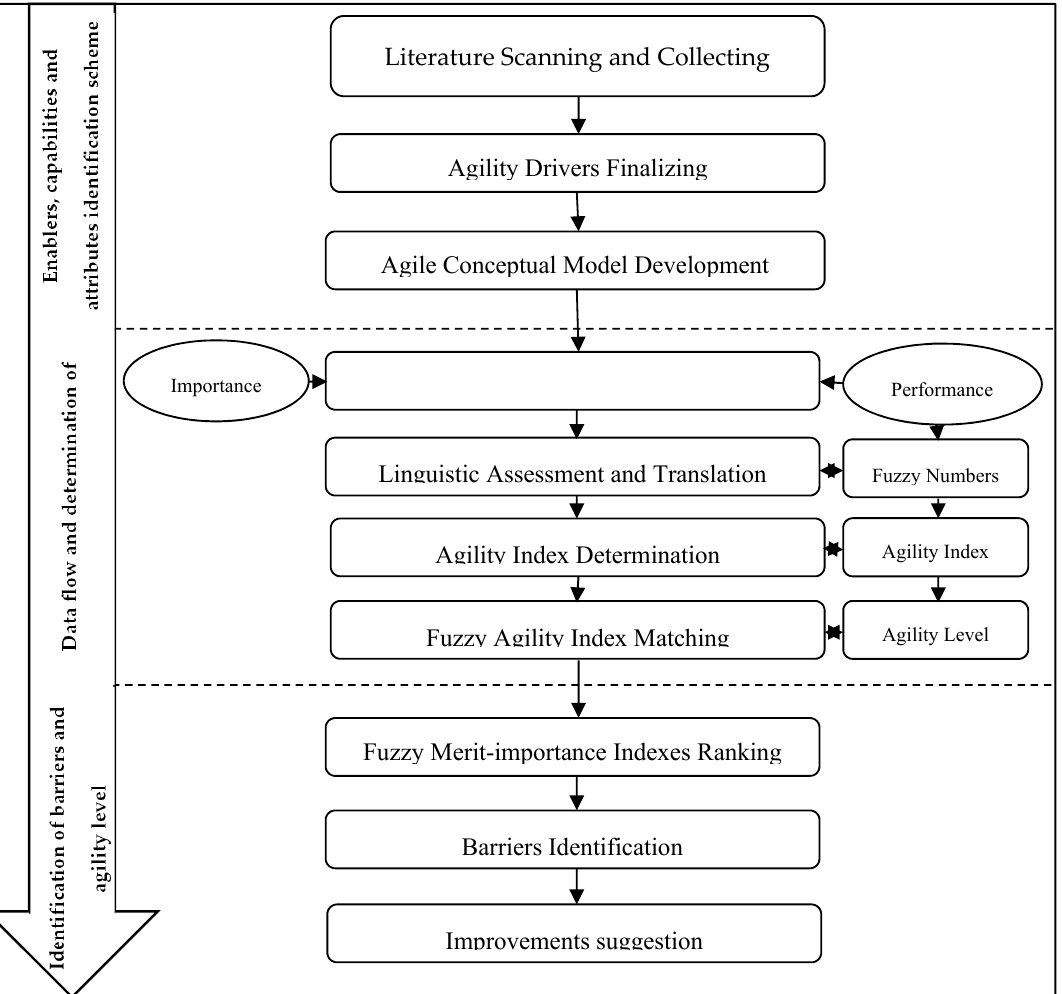
Figure 1. Methodology for evaluating supply chain agility.